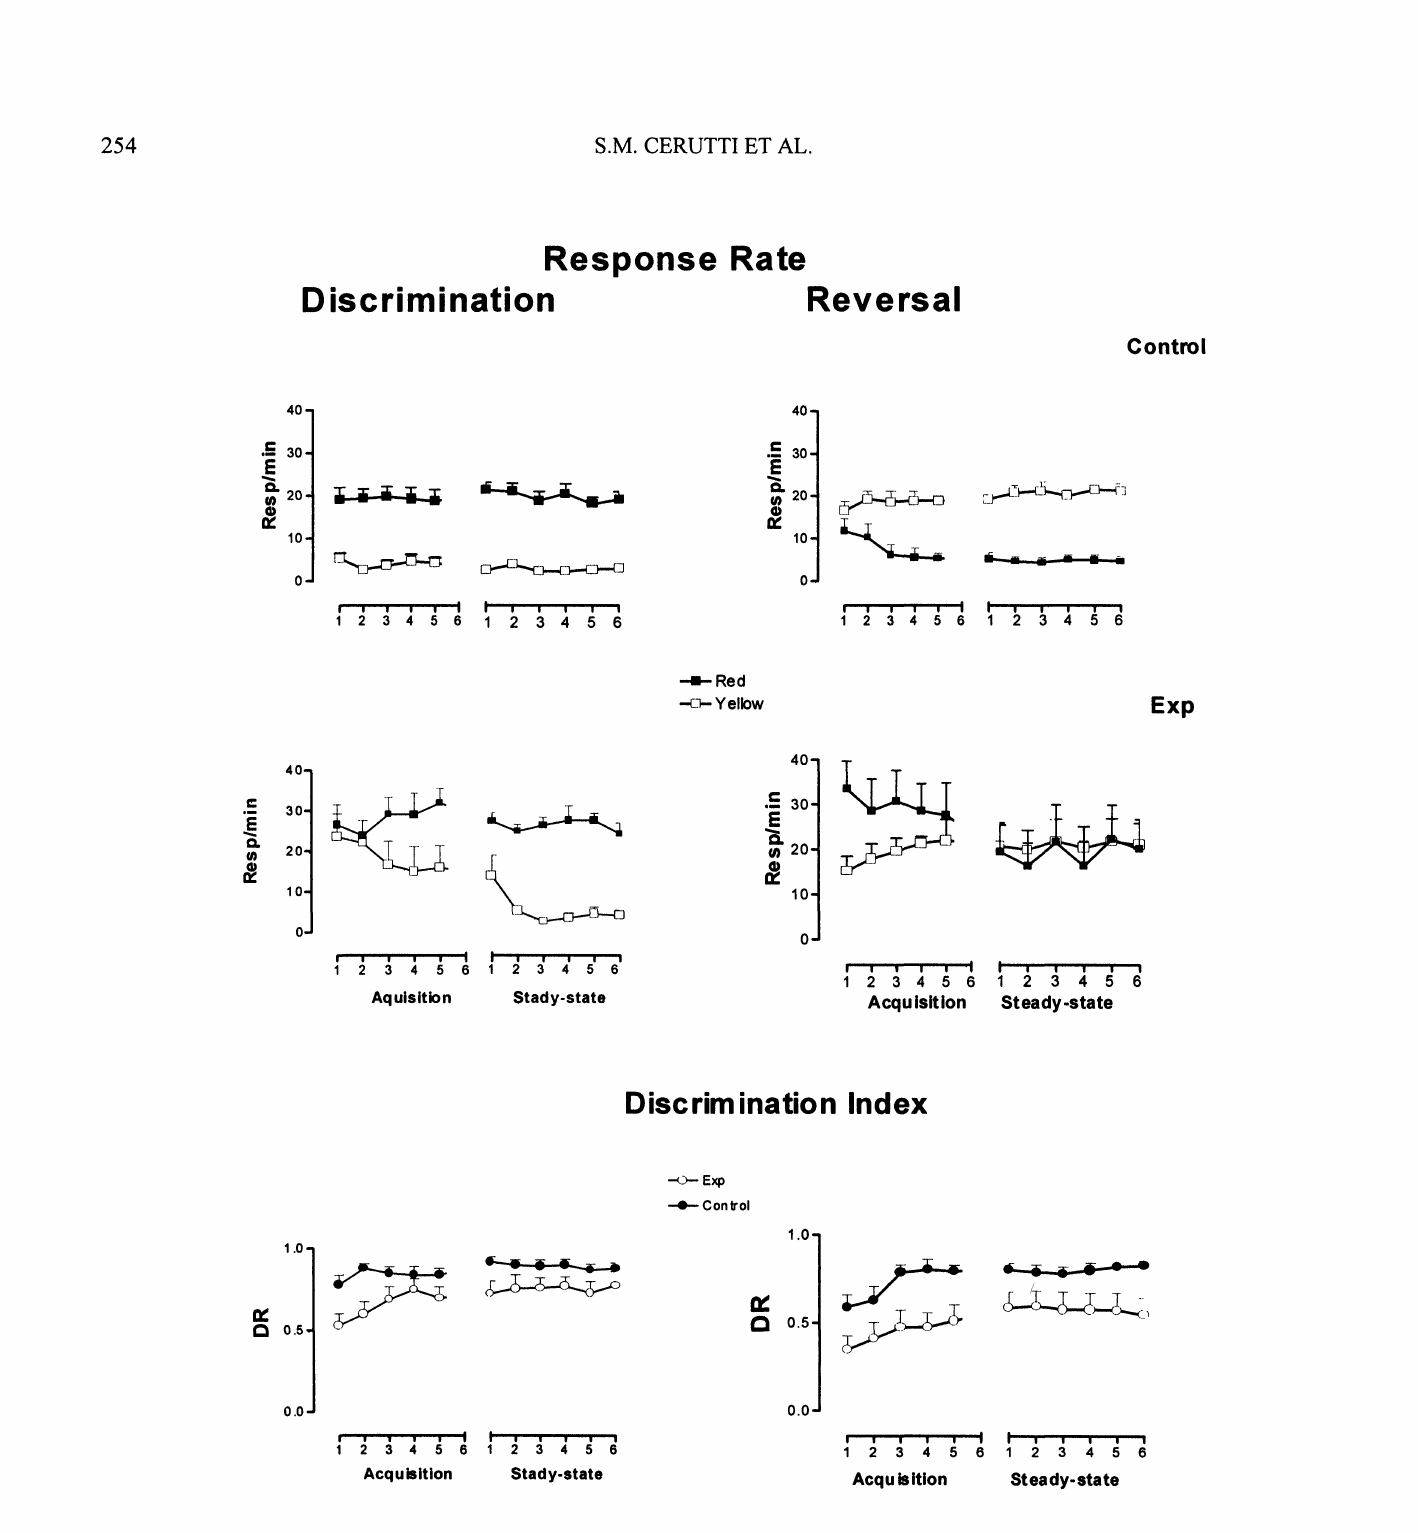
Fig. 3: Key pecking response rates in Red (square symbols) and Yellow (circle symbols) components of the Discrimination and Reversal situation, for telencephalon-lesioned (Exp) and Non-lesioned (Control) birds. Data are reported as mean group values, computed for each one of the first six training sessions (Acquisition) and the six criterion-sessions (Steady-state) (Top) Discrimination ratio (DR) expressed as relative response rates in red and yellow for Telencephalon-lesioned (Exp), Non-Lesioned (Control) groups (Bottom) Vertical bars indicate